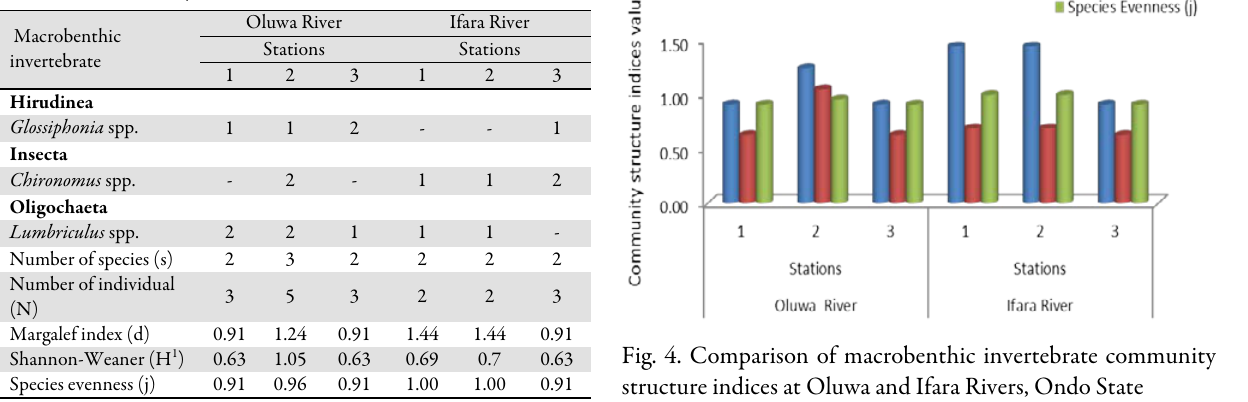
Table 5. The distribution, occurrence and diversity indices of macrobenthic invertebrates’ community at Oluwa and Ifara Rivers